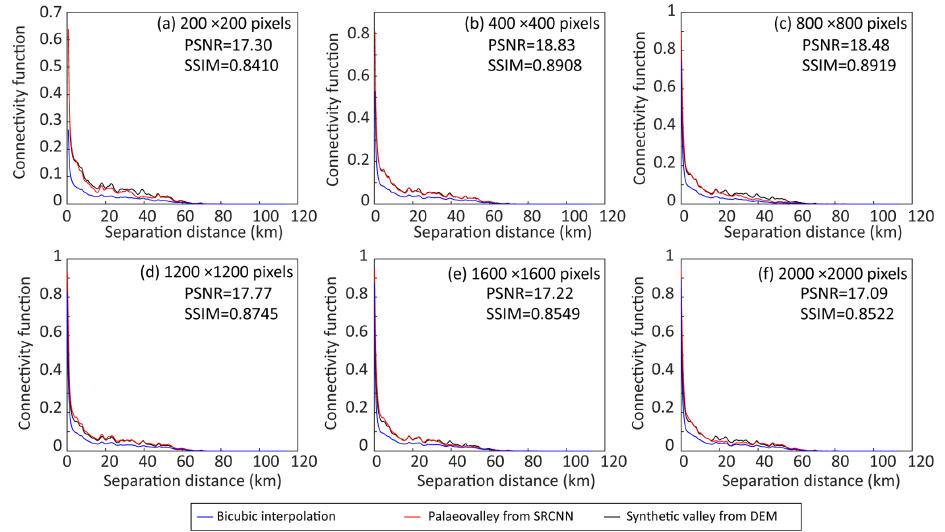
Figure 7. The PSNR, SSIM and connectivity of paleovalleys generated by SRCNN for different resolutions of upscaling the low-resolution EC image to a high-resolution binary paleovalley.